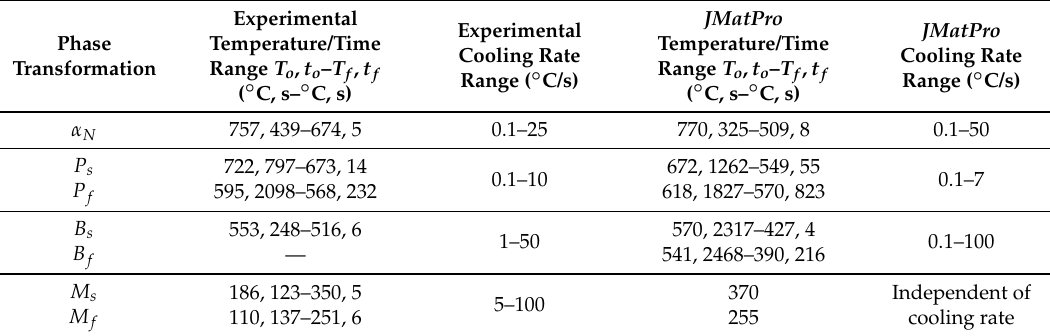
Table 2. Ranges of temperatures, times and cooling rates at which the different transformations are observed in the experimental and calculated continuous cooling transformation (CCT)